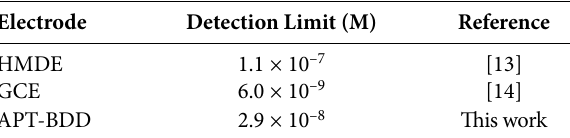
Table 1. Comparison of the efficiency of the anodically pretreated boron-doped diamond electrode (APT-BDDE), hanging mercury